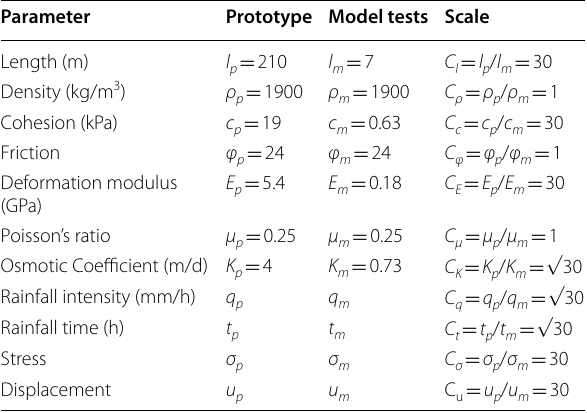
Table 1 Experimental model parameters and similarity